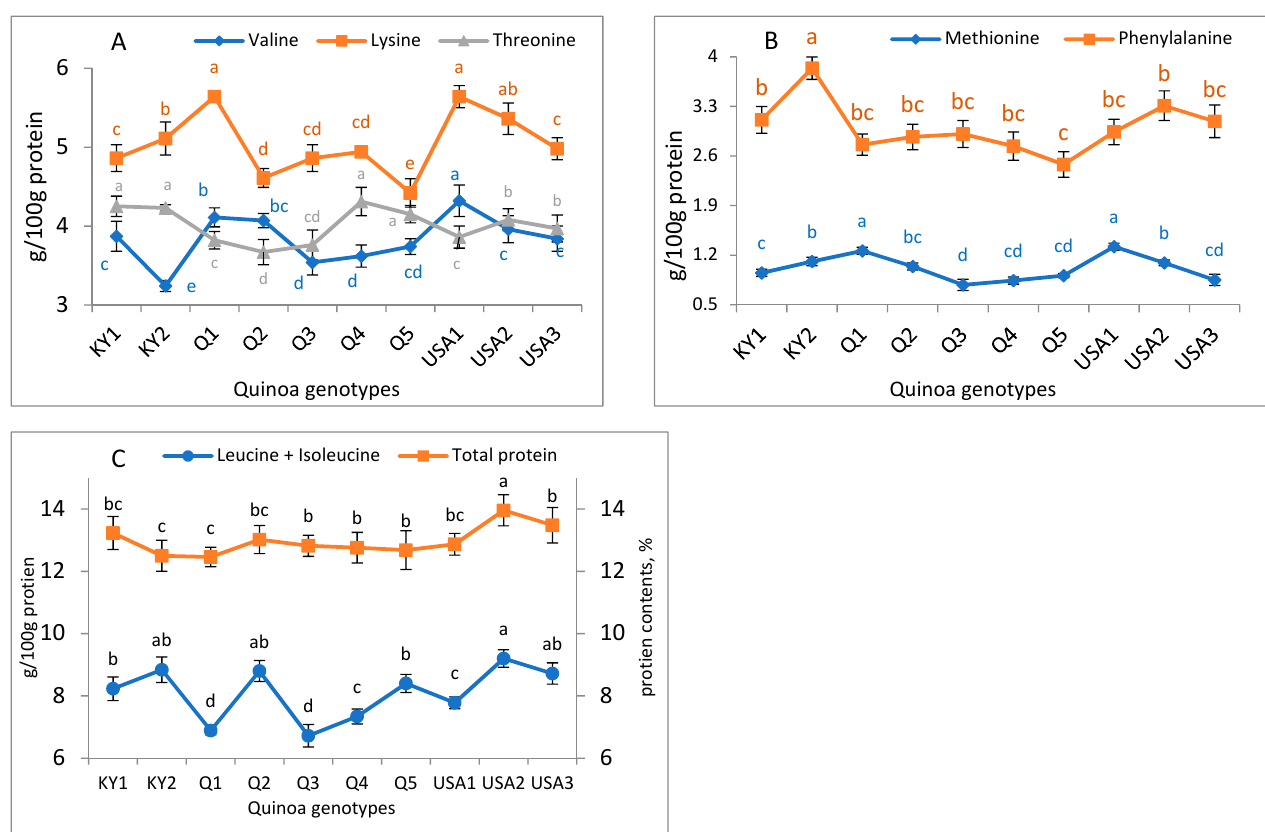
Figure 5. Protein percentages and amino acid contents (g/100 g protein) in quinoa grains. ( A ) Valine, lysine, and threonine contents; ( B ) methionine and phenylalanine contents; ( C ) leucine and isoleucine contents and protein percentages. The same letter(s) statistically not different ( p < 0.05). The Q1 and USA1 cultivars had the highest amounts of lysine (5.64 g/100 g protein),